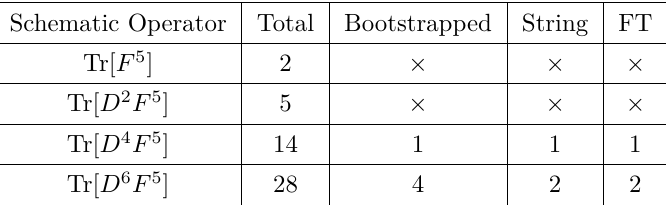
[1 + 2 + 3 + 4 + 5 + ] after imposing the KKBCJ re- Table 4 . Number of operators contributing to A R 5 lations in the generalized, string, and BAS form. We also list the total number of independent operators. The × indicates that no operator at that order is